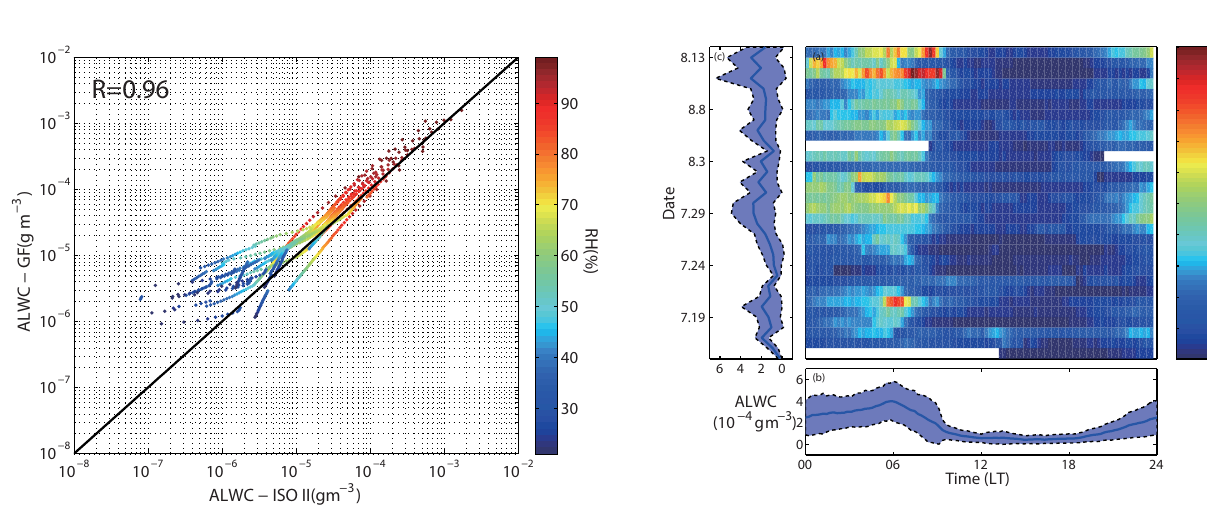
Figure 3. Comparison between ALWC calculated from measured growth factors (ALWC-GF) and modelled with ISORROPIA II (ALWC-ISO II); the colour of the dots present their corresponding RHs; the solid line shows the 1:1 line.